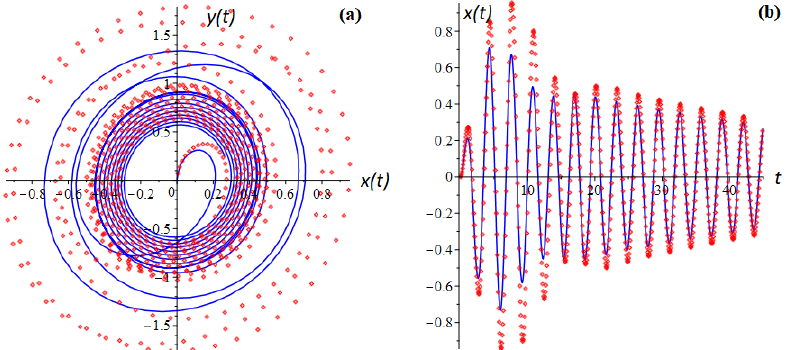
Figure 10. Phase trajectory ( a ) and waveform ( b ) for the Cauchy problem (1) obtained by explicit (7) and implicit (8)